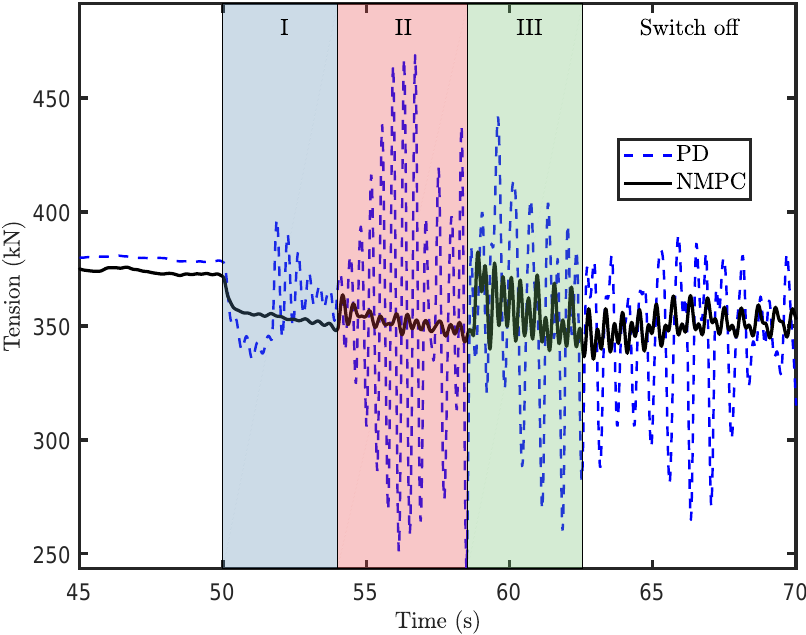
Figure 14. Comparison of the time-domain simulation results of the tension on the lift wire, γ = 0.5, mean wind speed 12 m/s, TI =